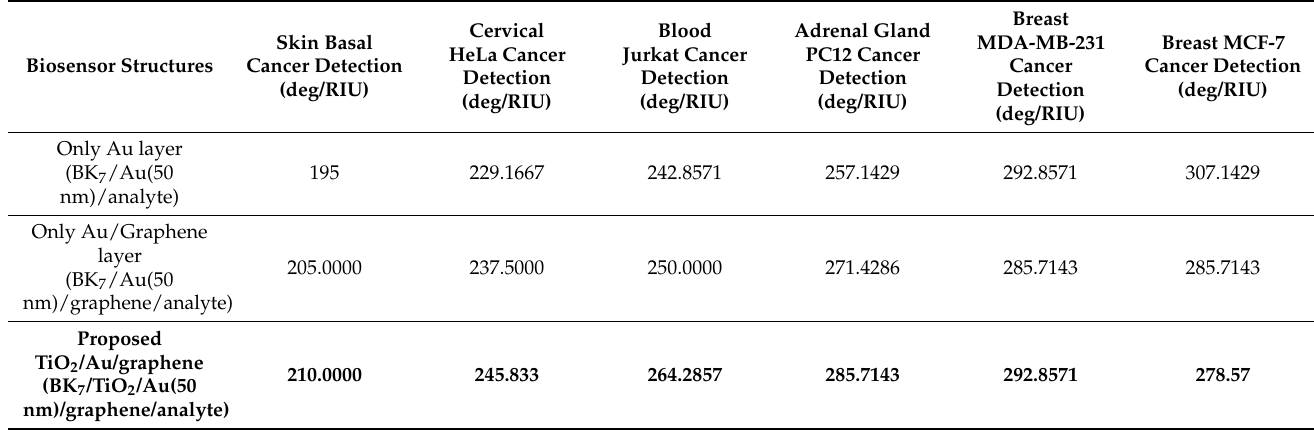
Table 3. Impact of material layers on the sensitivity of various types of